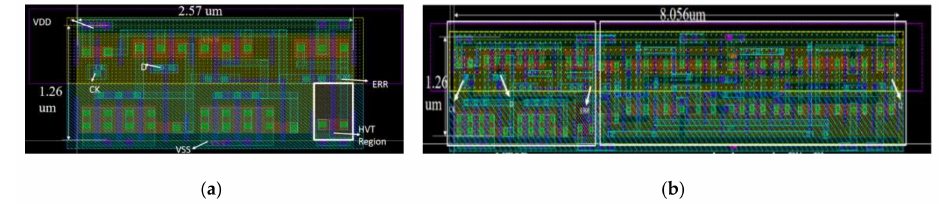
Figure 9. Layouts for the proposed ( a ) NTSD and ( b )